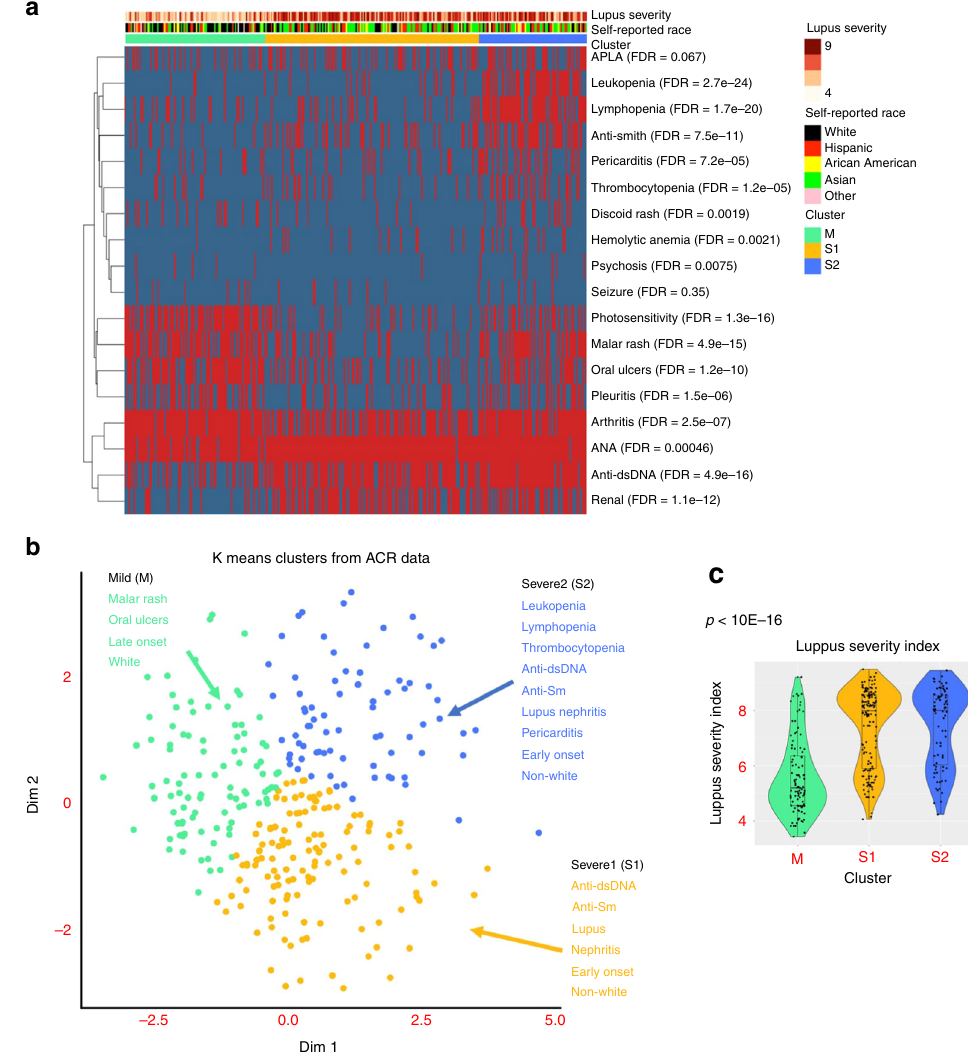
Fig. 2 Characterization of clinical features between clusters. a Distribution of American College of rheumatology (ACR) classi fi cation criteria for SLE within each cluster where red indicates presence and blue absence of each criterion. Association between each criterion and cluster was evaluated by a Fisher exact test. b Criteria signi fi cantly associated with each cluster (FDR < 0.01). c Distribution of lupus severity index across clusters with p -value